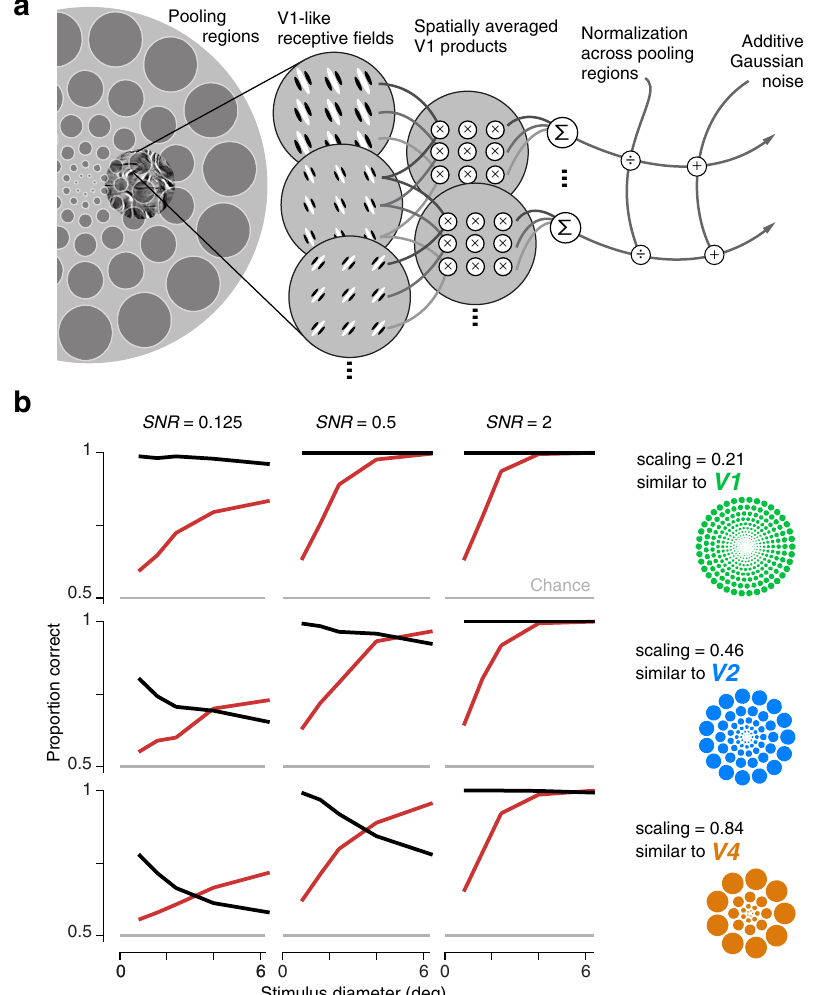
Fig. 3 A two-stage observer model predicts opposing perceptual effects. a Starting from V1-like responses (recti fi ed responses of oriented fi lters), the model computes 668 local pairwise statistics over pooling regions whose sizes grow in proportion to eccentricity (depicted in cartoon form as nonoverlapping discs — actual model responses are computed with smoothly overlapping weighting functions that cover the visual fi eld). Each summary statistic is normalized by the magnitude of responses across all pooling regions, and corrupted by Gaussian noise. The observer response is obtained by computing the Euclidean distance between response vectors for both pairs of images as in the psychophysical AXB design, and selecting the pair with the larger distance. Performance for each condition of noise level, scaling, and stimulus diameter is computed by averaging simulations over 10,000 repeated experiments on 15 samples from four families (as in the perceptual experiments). b Performance on family (red) and sample (black) discrimination tasks, as a function of stimulus diameter, for observer models with three different levels of noise and three different scaling values. The average signal-to-noise ratio (SNR) was computed separately for each scaling by dividing the variance in responses across all stimuli and pooling regions by the variance of the Gaussian noise. Scaling values (stimulus diameter divided by eccentricity) are matched to estimates from visual areas V1, V2, and V4. Source data are provided as a Source Data fi